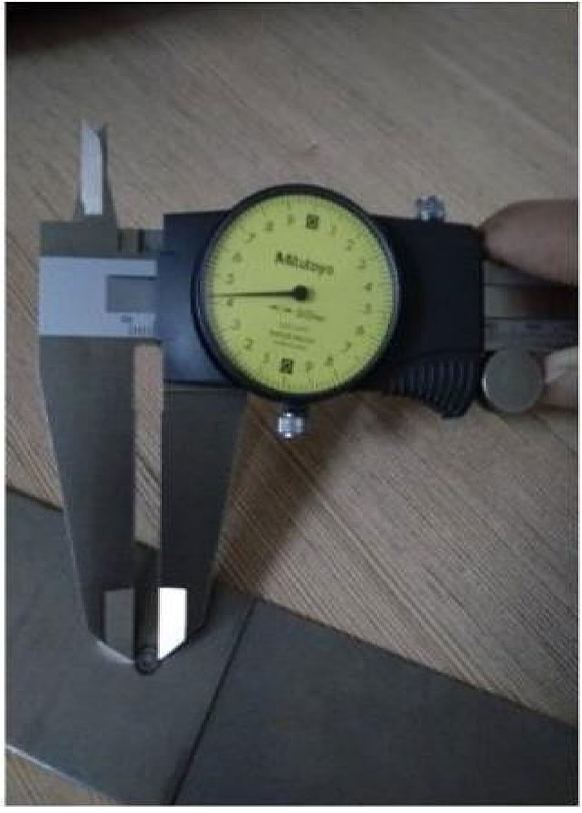
Fig. 8 Measurement of Nugget